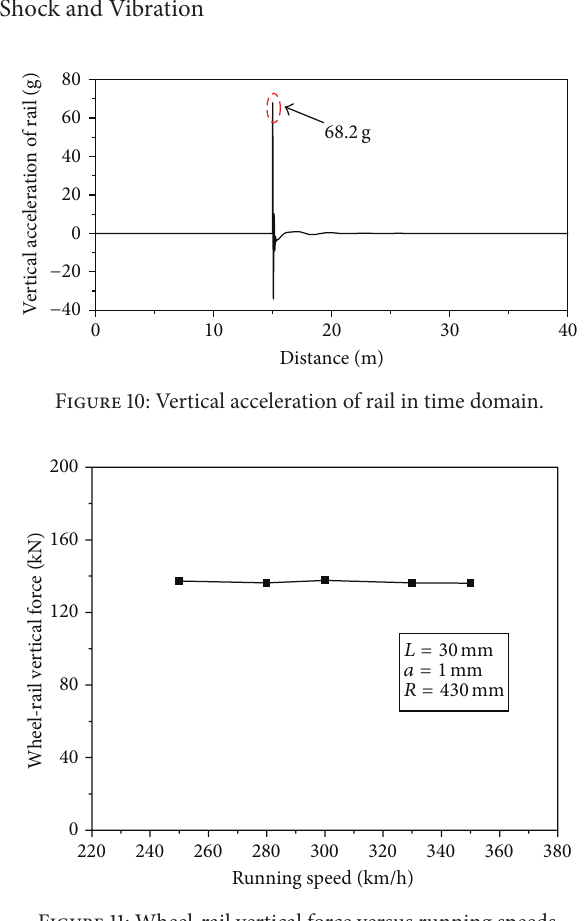
Figure 11: Wheel-rail vertical force versus running speeds.